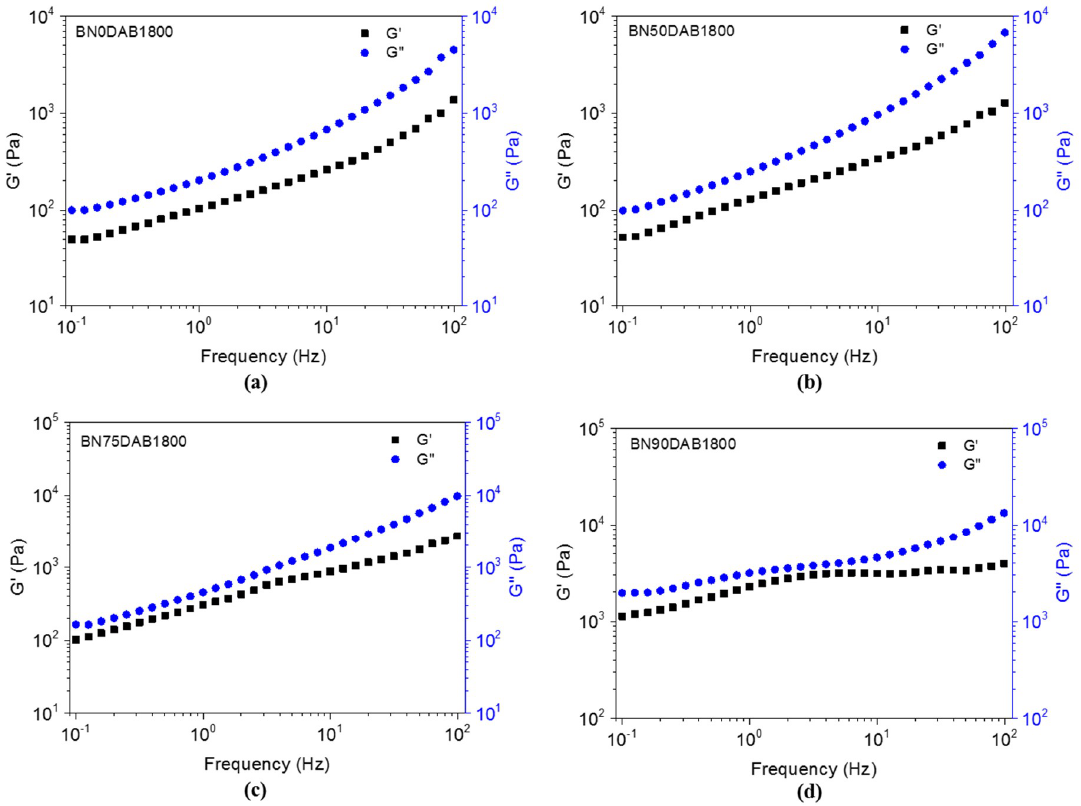
Figure 3. Dynamic modulus versus frequency of ( a ) BN0DAB1800, ( b ) BN50DAB1800, ( c ) BN75DAB1800, and ( d ) BN90DAB1800. See Table 1 for descriptions of composites.